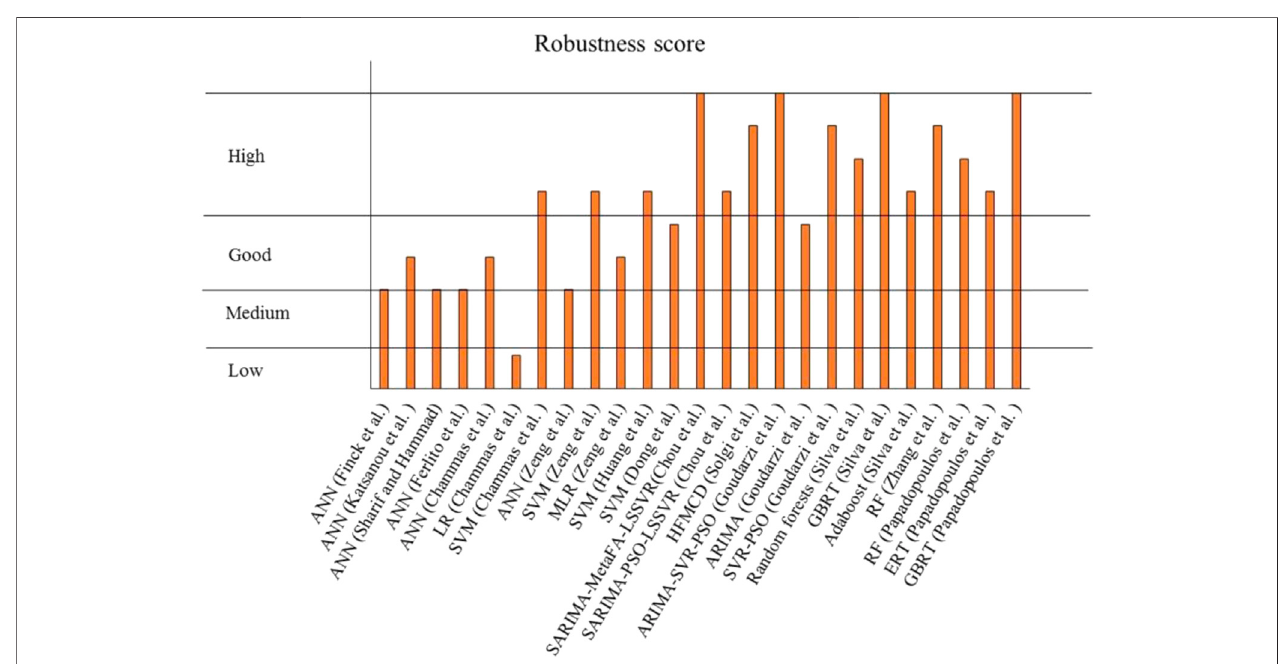
FIGURE 7 | Robustness score for BE consumption prediction methods.